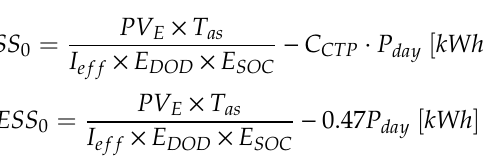
Figure 1. The set-off power in a day.